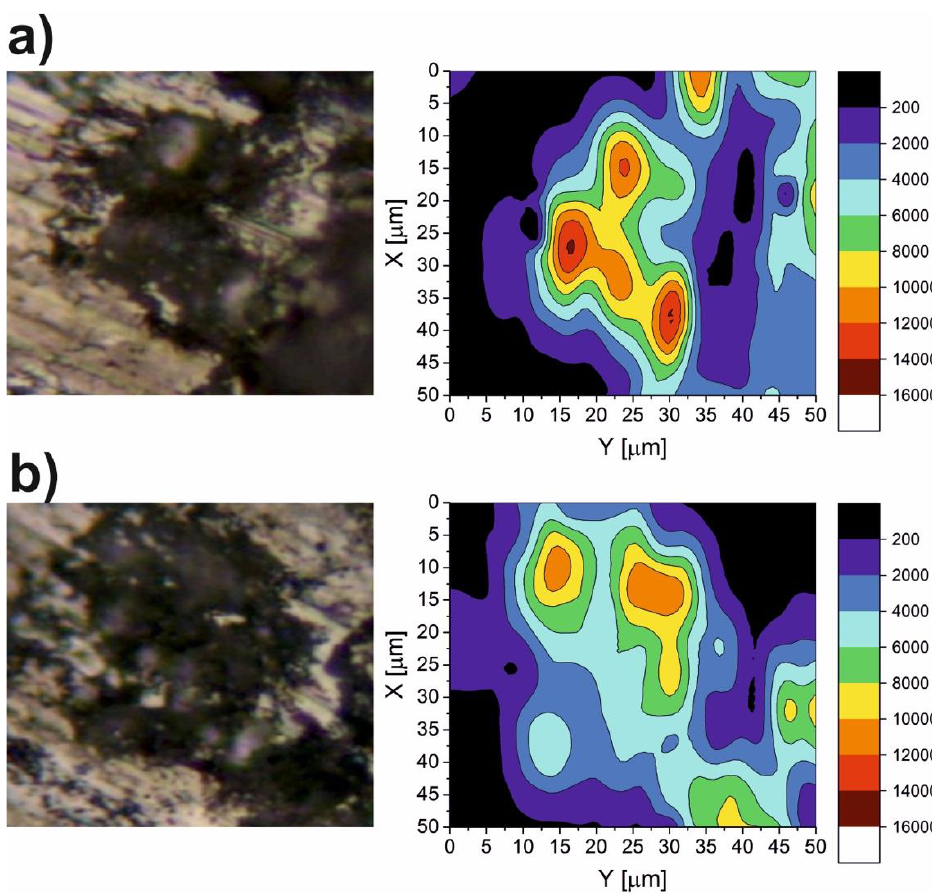
Figure 11. The Raman maps of Ni-10% CaF 2 ( a ) and Ni-20% CaF 2 ( b ) self-lubricating composites after wear test at room temperature.